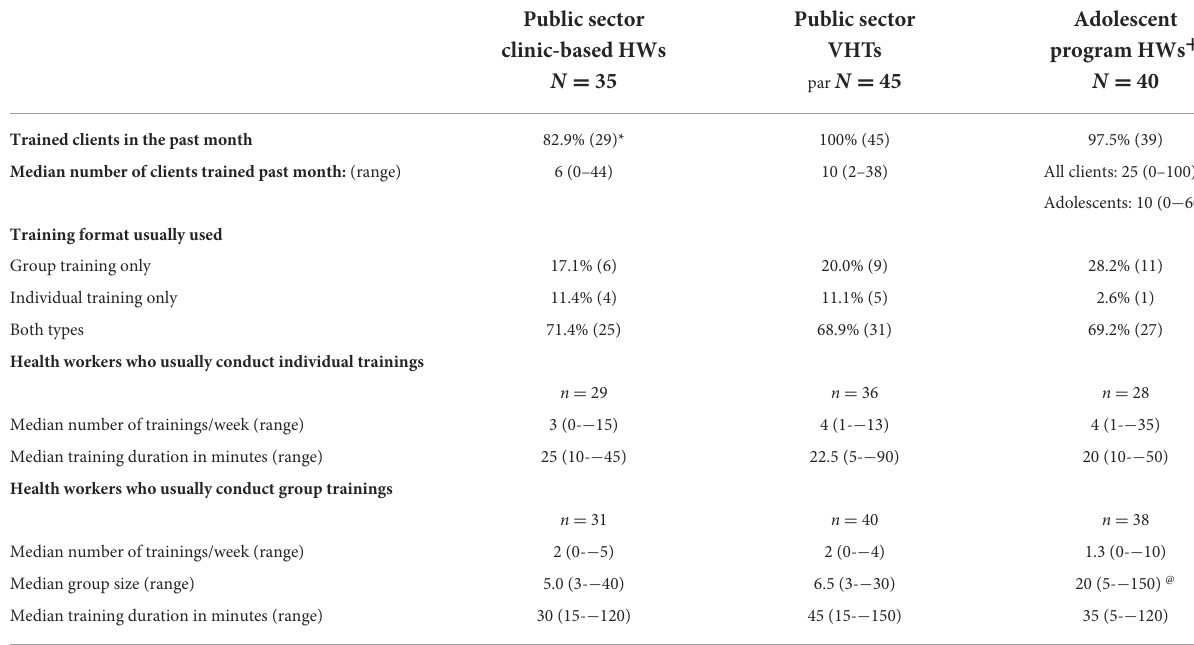
TABLE 2 Provider-reported frequency and style of self-injection training